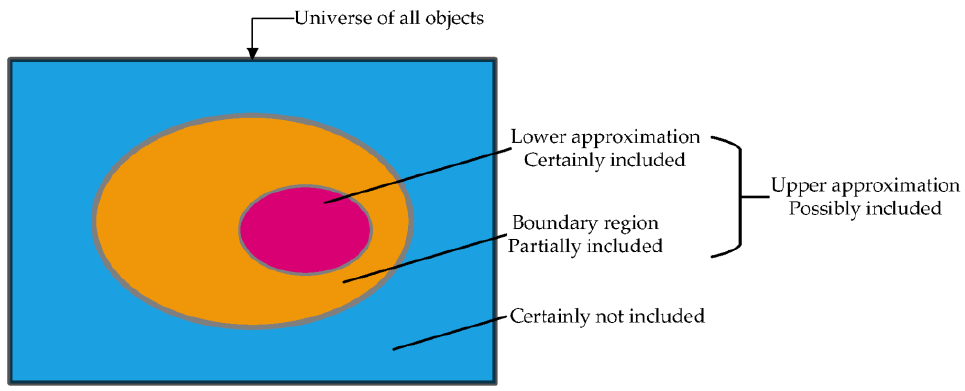
Figure 3. The basic concept of rough set theory.